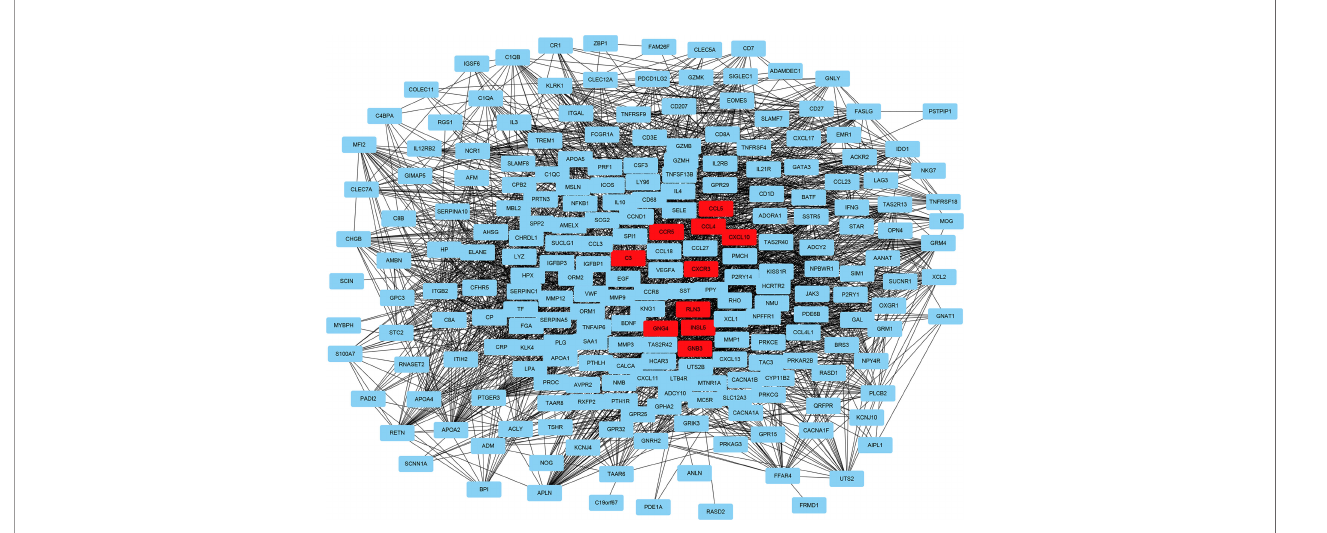
FIGURE 5 | Reconstructed protein – protein interaction network using Cytoscape. The ten hub genes with the highest connection degree are indicated in red.